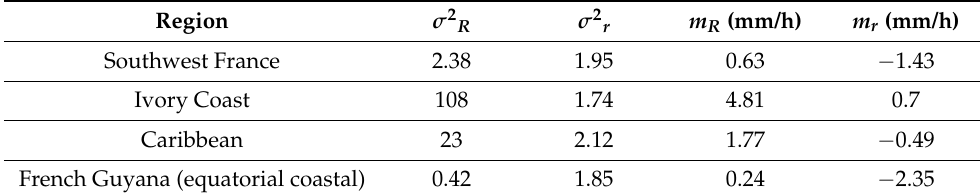
Table 1. Typical parameters for various regions. Region